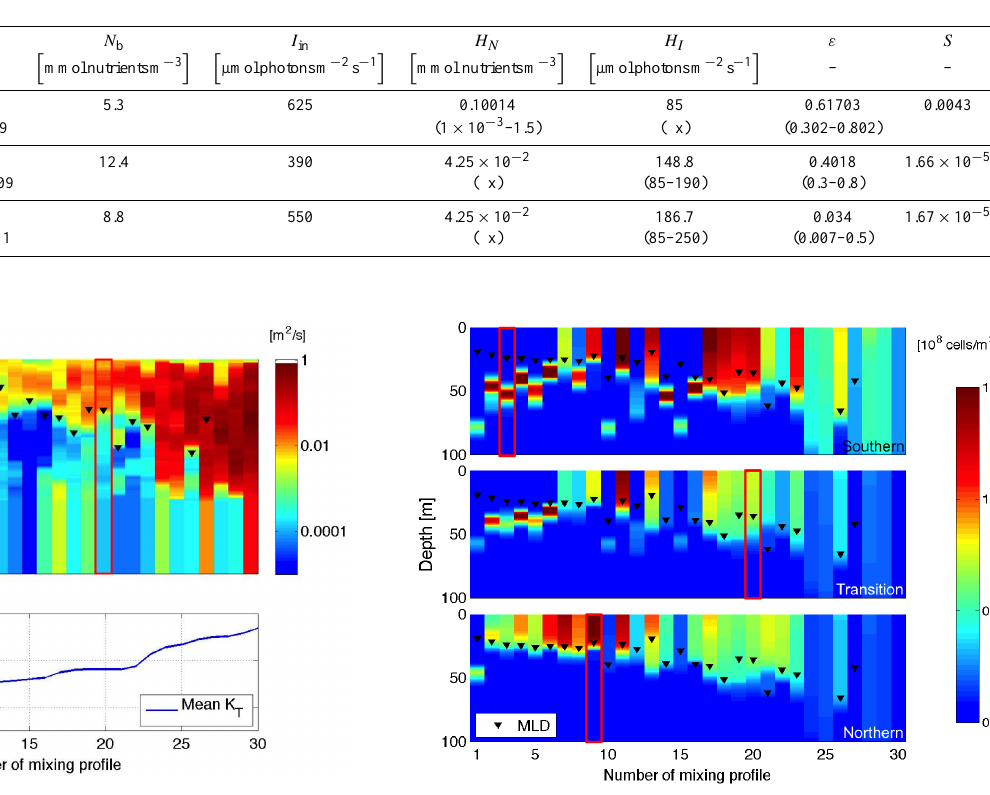
Figure 10. Phytoplankton concentration results of the sensitivity study based on the vertical mixing shown in Fig. 9 and the three Fig. 10: Phytoplankton concentration results of the sensitiv- reference stations: southern, transition and northern (top to bottom). ity study based on the vertical mixing shown in Fig 9 and The red boxes show the respective reference the three reference stations: southern, transition and northern (top to bottom). The red boxes show the according reference state.